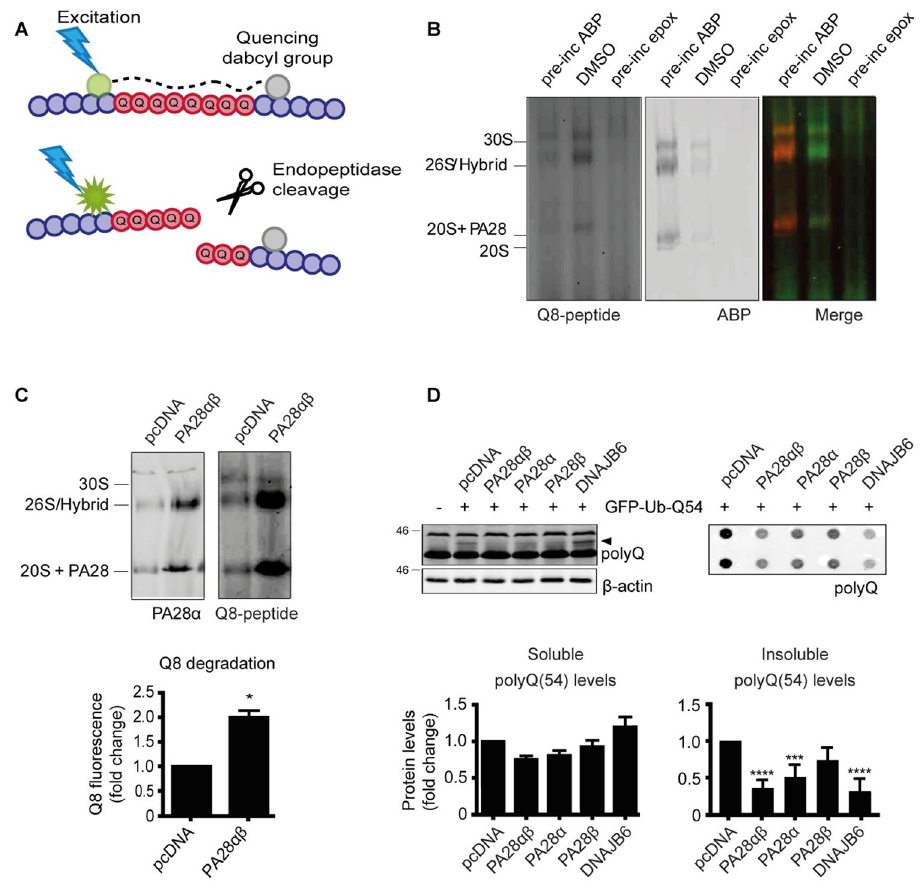
Fig 2. Addition of PA28 αβ increases degradation of polyQ peptides. (A) Illustration of qQ8 peptides, which are used to show polyQ endopeptidase activity. These peptides include eight glutamine residues (represented in red) which are flanked by non-degradable D-amino acids (represented in purple) at both peptide termini to prevent degradation by exopeptidases. Upon cleavage within the polyQ sequence, the C-terminal quencher (in grey), and N-terminal fluorophore (in green), are separated which will result in the emission of fluorescent signal. (B) Proteasome activity labeling by ABP and qQ8-peptide degradation on native PAGE. (C) Native PAGE showing improved polyQ degradation after PA28 αβ overexpression in HEK293 cells. Data are normalized to WT HEK cells and shown as mean ± SEM (n = 3). One-sample t-test; PA28 αβ p = 0.0170. � p < 0.05. Pre-inc: Pre-incubated. (D) PA28 α and PA28 αβ overexpression in HEK293 cells improves the clearance of insoluble polyQ peptides. Data are normalized to pcDNA transfected cells and shown as mean ± SEM (soluble n = 3; insoluble n = 4). One-way ANOVA with Dunnet’s multiple testing; for soluble mHTT PA28 αβ p = 0.1612; PA28 α p = 0.3313; PA28 β p = 0.9235; DNAJB6 p = 0.3006; for insoluble mHTT PA28 αβ p < 0.0001; PA28 α p = 0.0010; PA28 β p = 0.0788; DNAJB6 p < 0.0001. ��� p < 0.001; ���� p < 0.0001. Pre-inc = pre incubation; ABP = activity based probe; epox =